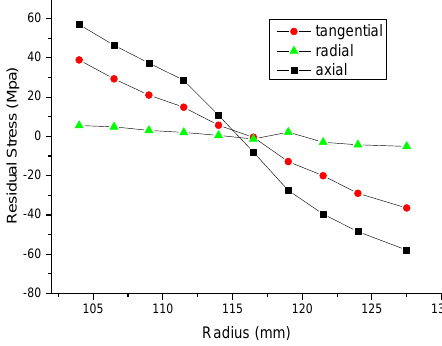
Figure 8. Ring-rolling residual stress along the radial direction.